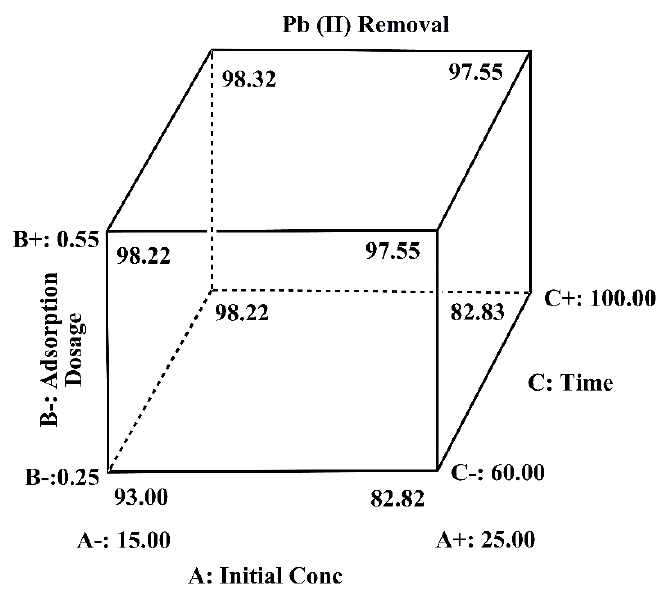
Figure 5. Cubic representation of independent variables response [209] . 579